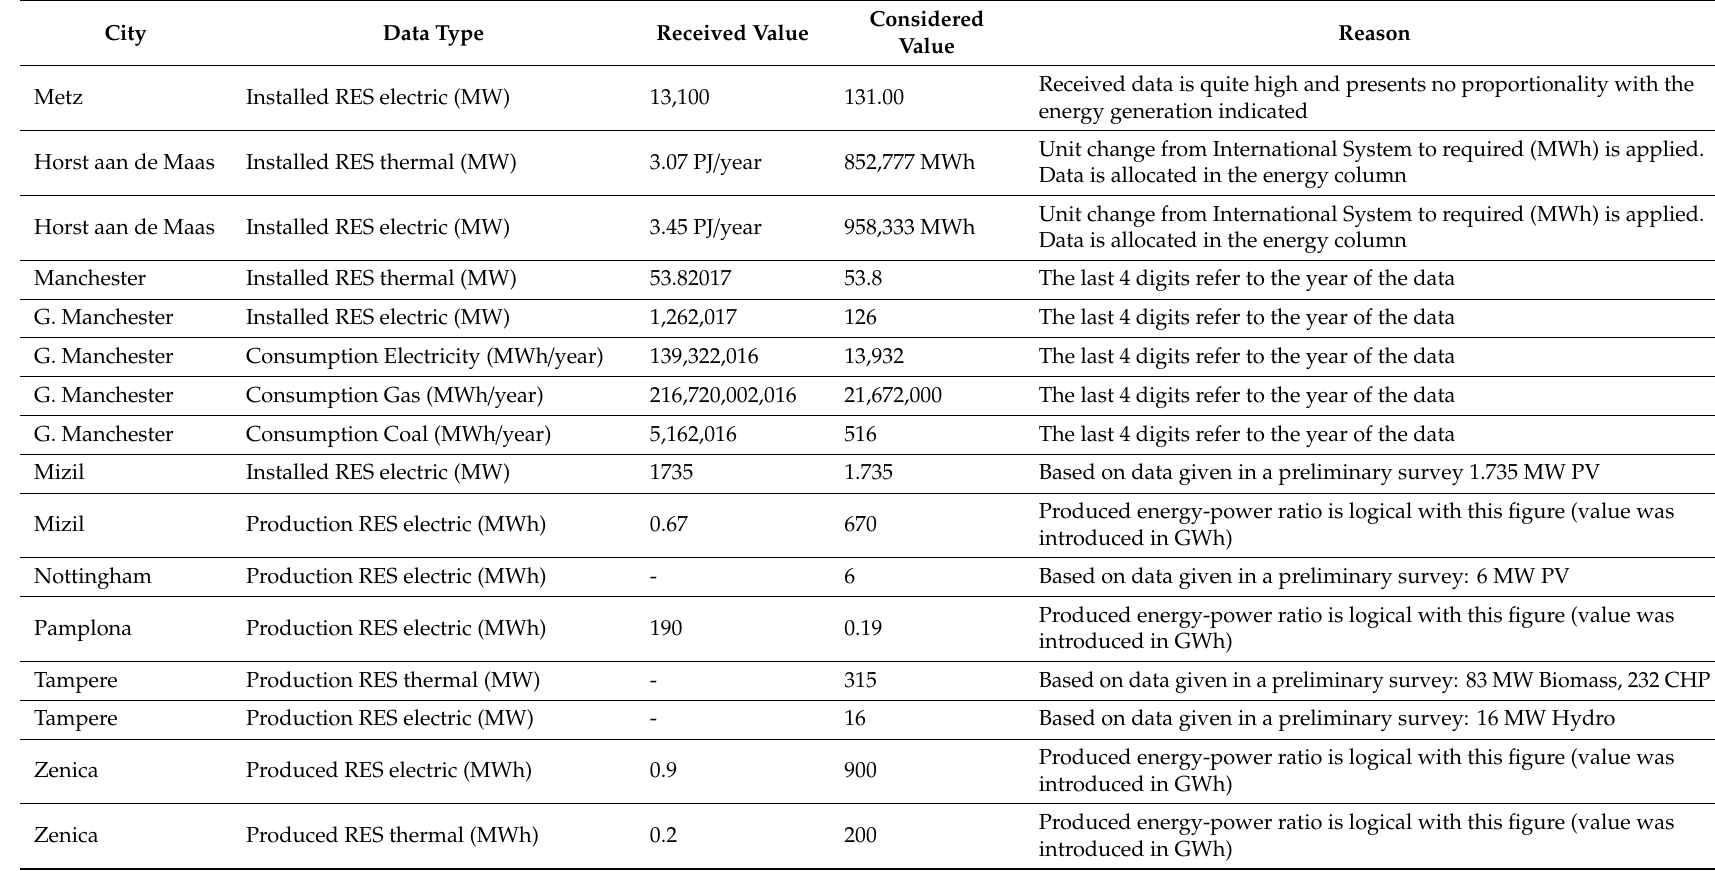
Table A1. Interpretation of some of the received RES